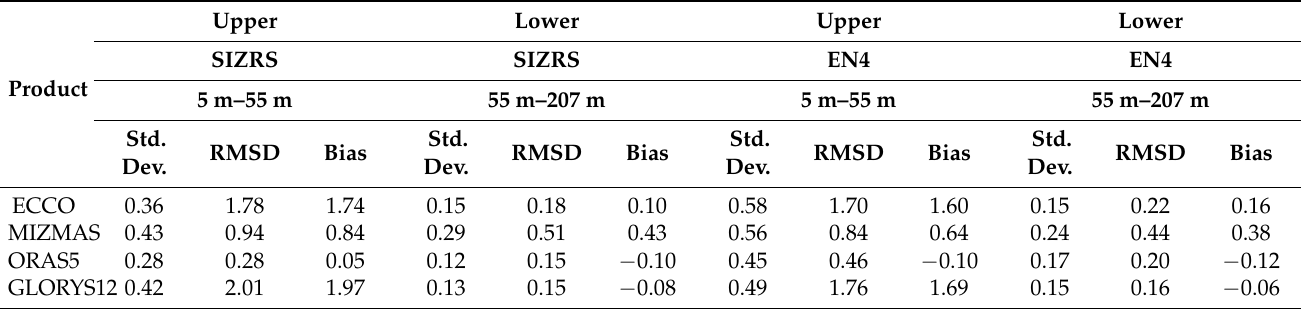
Table 4. Standard deviation of salinity (psu) profile differences between model minus in situ (SIZRS and EN4) products for the upper region (above 55 m depth) and lower region (below 55 m